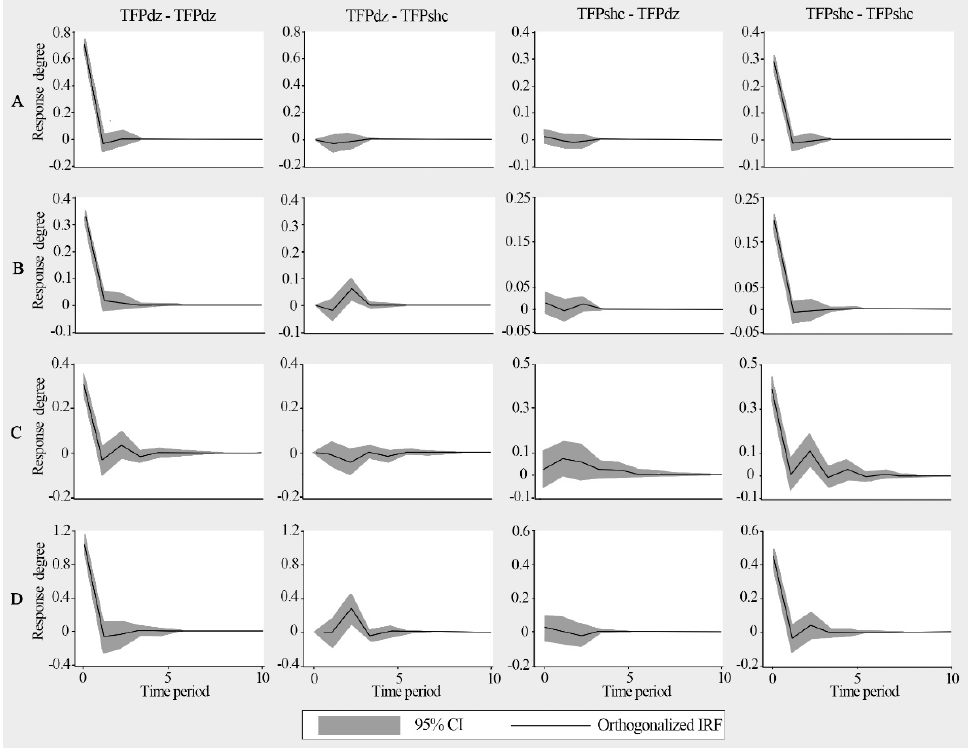
Figure 4. Graph of the results from the impulse response function. ( A ) The whole country panel, ( B ) the eastern region panel, ( C ) the central region panel, and ( D ) the western region panel.